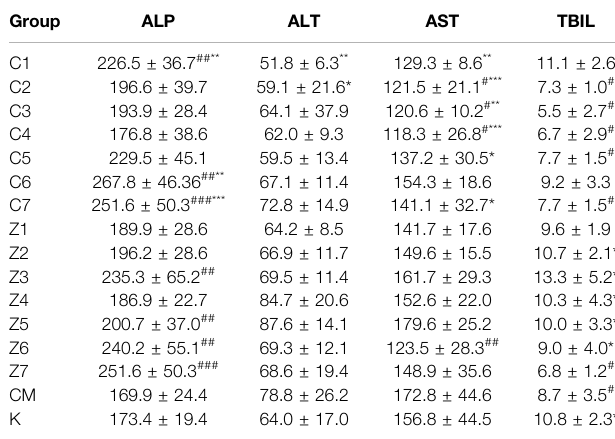
TABLE 3 | Liver function indexes in CUMS and healthy rats administration with PBR (Mean ± SD, n (cid:1)